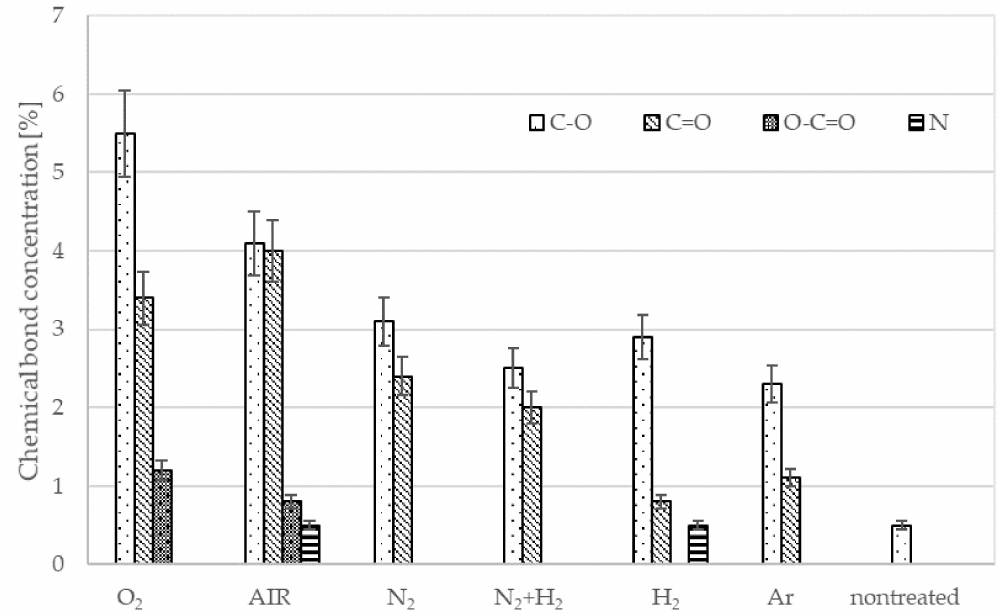
Figure 8. The composition of the surface film as deduced from XPS survey